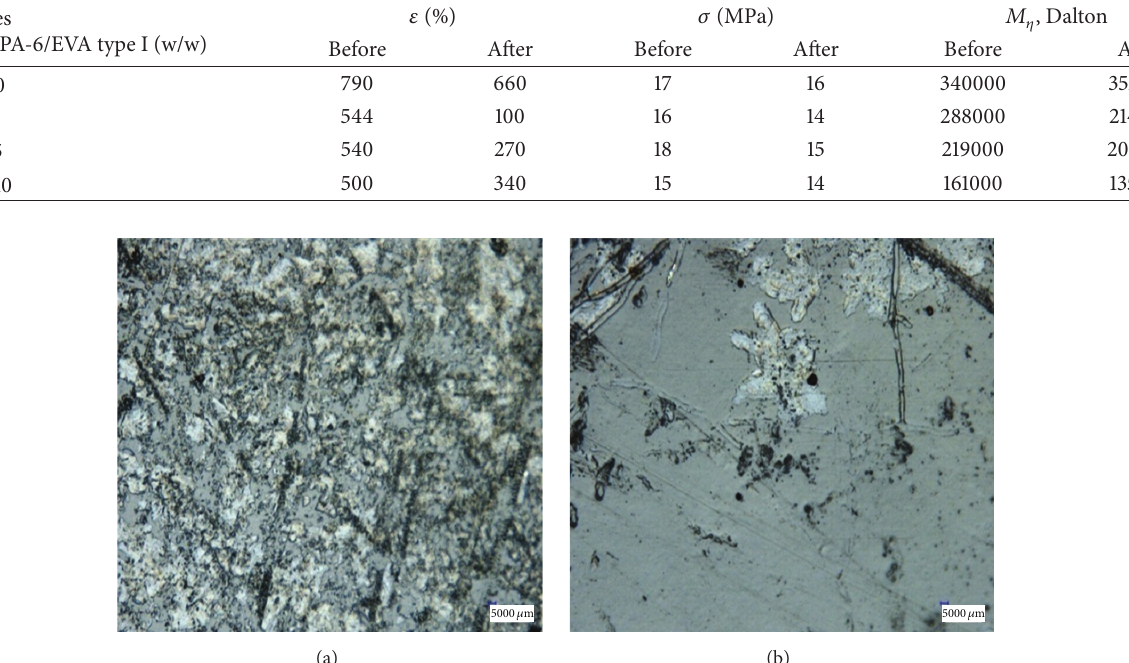
Figure 6: Micrographs of the film surface of polymer composite LDPE (80wt.%), PA-6 (10wt.%), and EVA type I (10wt.10%) (enlargement 5000x) before biodegradation (a) and after biodegradation for 28